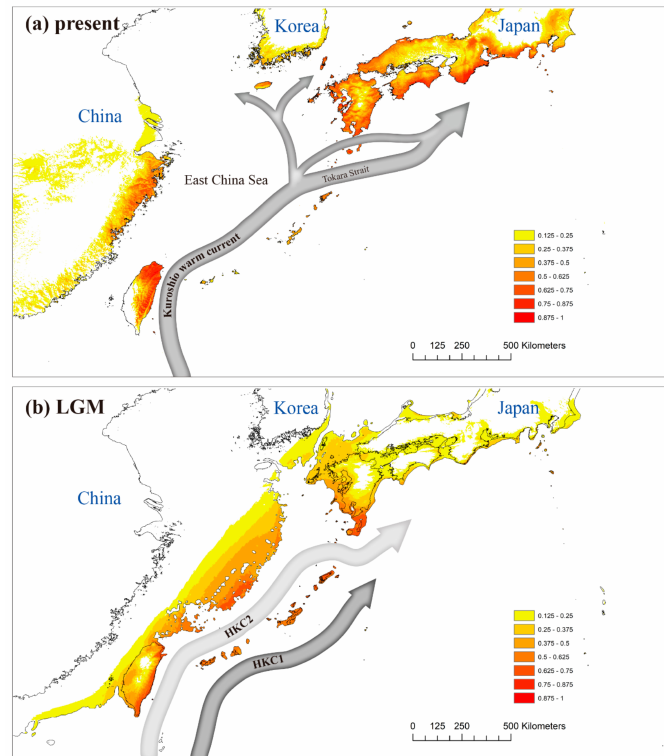
Figure 7. Potential distributions of Quercus gilva during ( a ) the present; ( b ) the Last Glacial Maximum, LGM. Distributions predicted by ecological niche modeling; potential distribution during the LGM was averaged from three general circulation models. HKC 1 indicates the main track of the Kuroshio Current during the LGM proposed by Ujiie et al. [66], Kao et al. [67], and Zheng et al. [68]. HKC 2 is the hypothetical Kuroshio Current during the LGM suggested by Vogt-Vincent and Mitarai